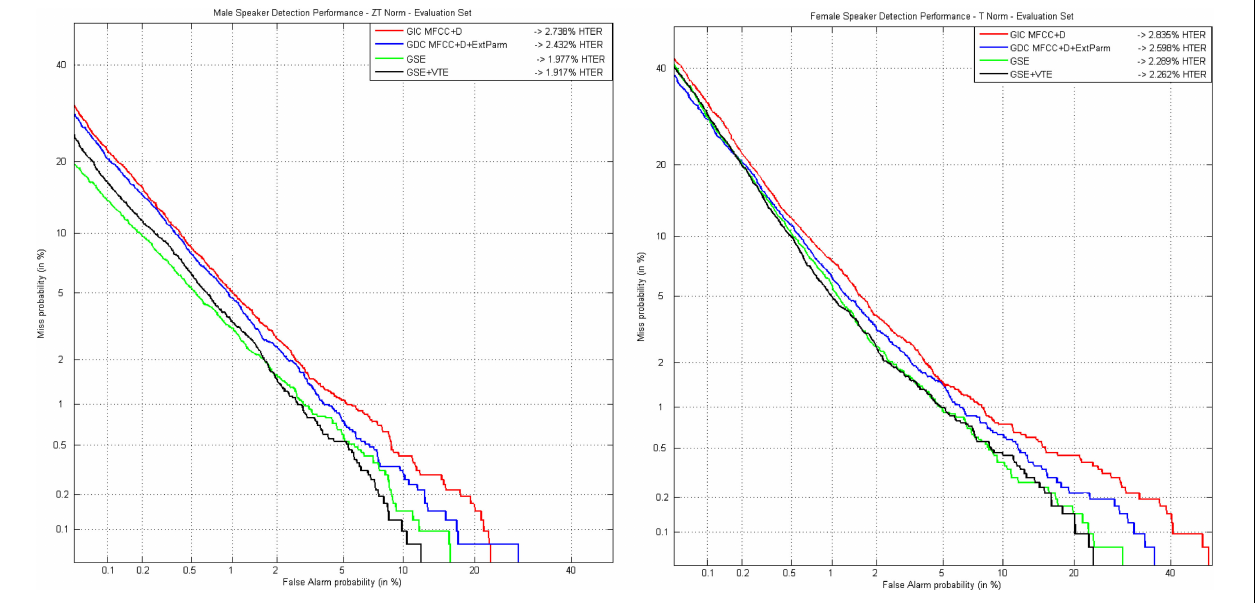
Frontiers in Bioengineering and Biotechnology |